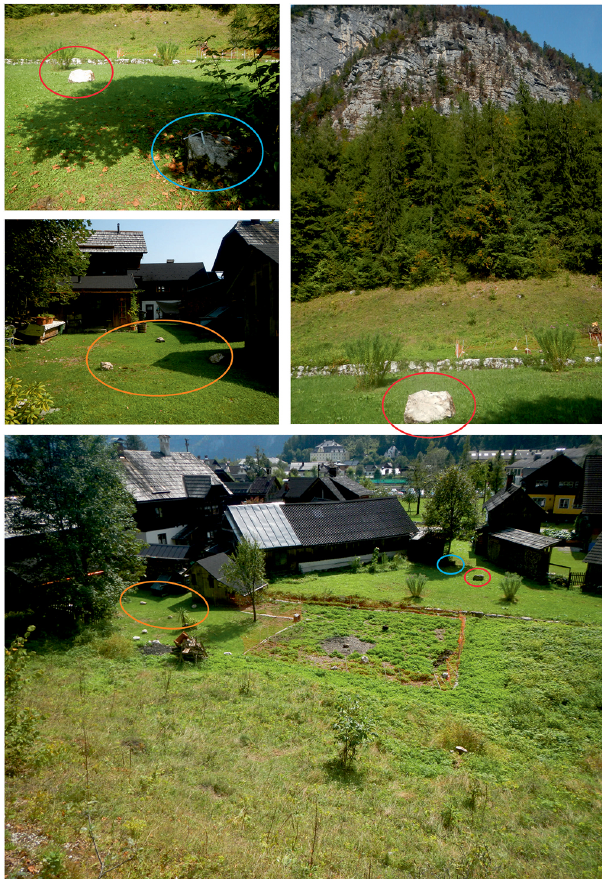
Figure 3. Rockfall boulders which were detached during the wild- fire and reached the settlement area. An older rockfall boulder (blue circle) marks the maximum reach of past rockfalls and has a volume of about 0.2m 3 (0 . 8 × 0 . 6 × 0 . 4); the fresh boulder (red circle) has a volume of about 0.3m 3 (0 . 8 × 0 . 75 × 0 .